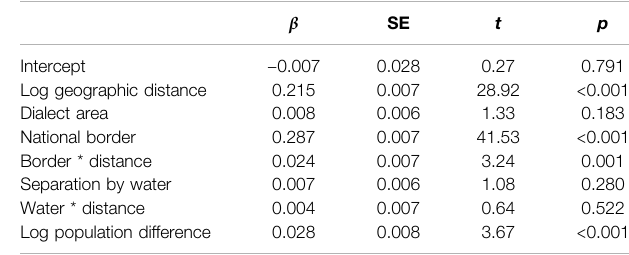
TABLE 13 | Linear mixed-effect modeling results for the Human body domain, showing beta coef fi cients, standard errors, t-values and signi fi cance levels. β